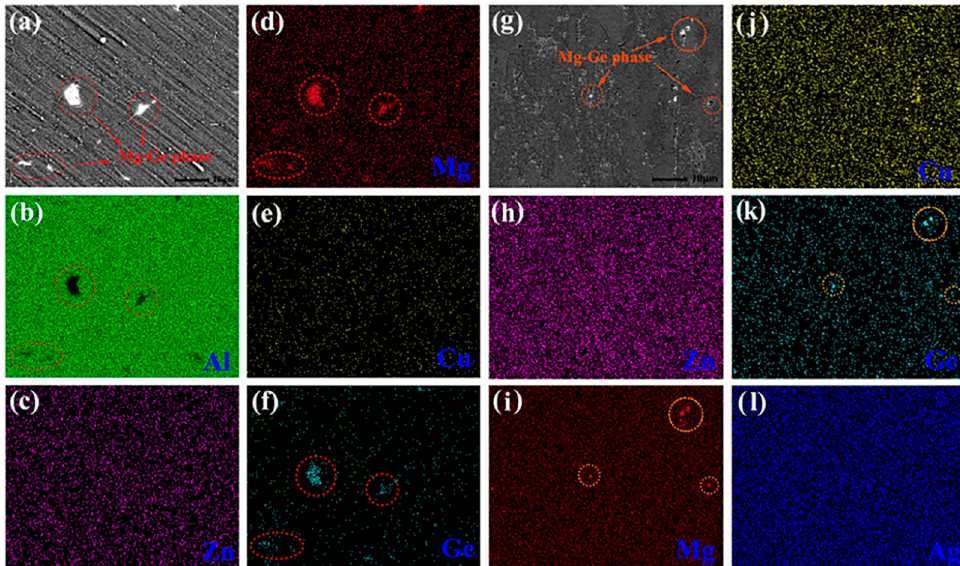
Figure 14. SEM image and element mapping of Ge-added alloy ( a – f ) and (Ge+Ag)-added alloy ( g – l ) subjected to aging at 120 °C for 25 h after air cooling. The Ge-containing particles are marked by red circles. [71].